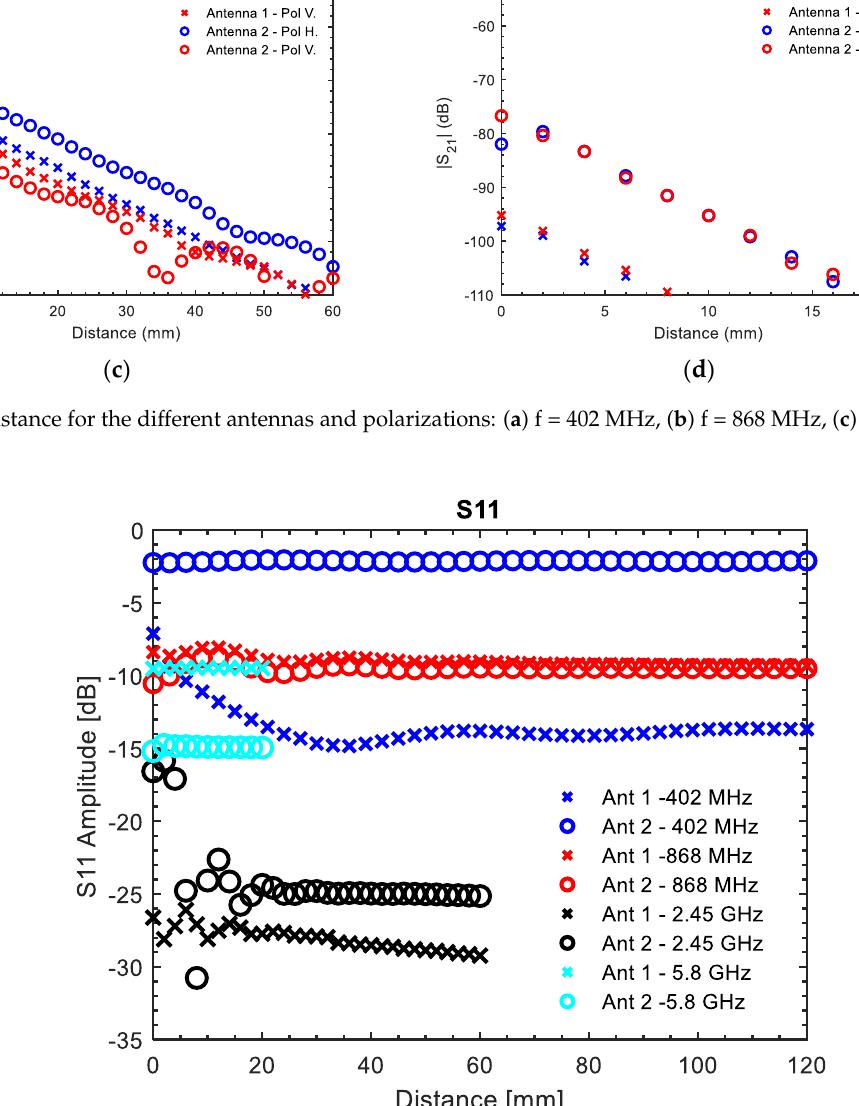
Figure 9. S 11 dB vs. distance for each antenna at different frequencies.